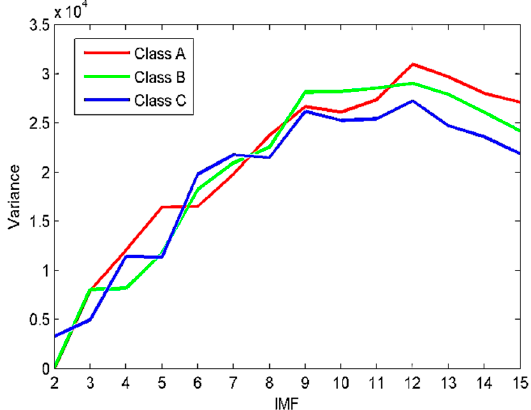
Figure 13. The results of variance analysis for the SRN signals.